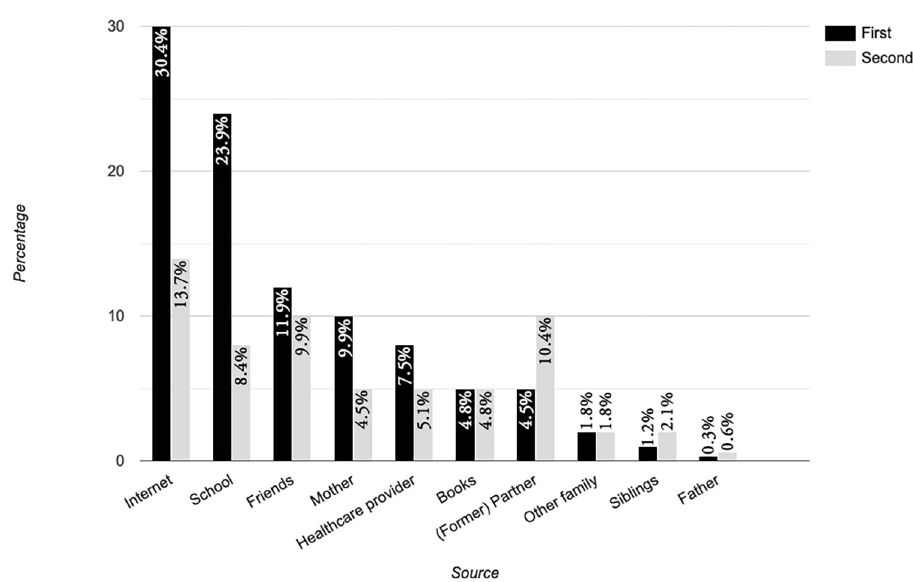
Fig 9. Sources of